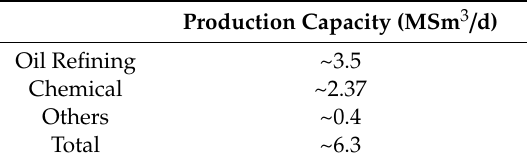
Table 6. Steam methane reforming (SMR) hydrogen production capacities by sector in Ontario